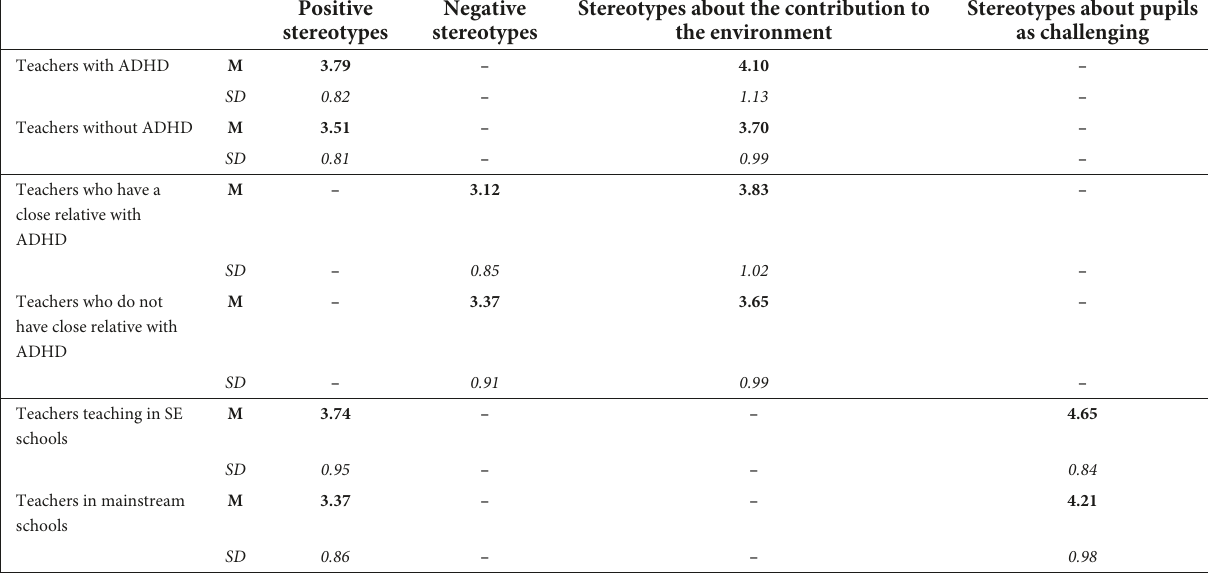
TABLE 1 Significant differences between means of main research